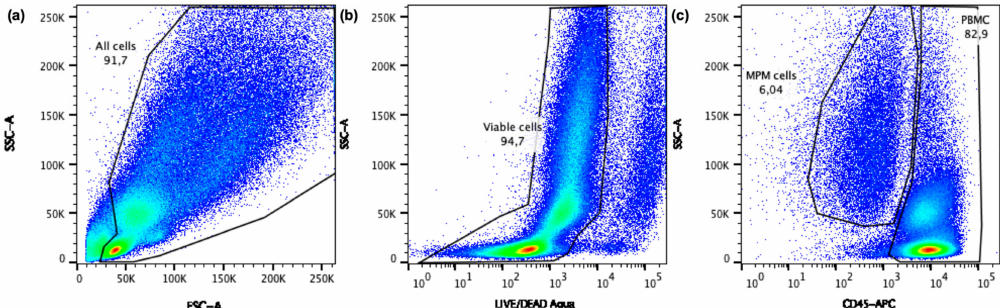
Figure 6. Flow cytometry gating strategy. The dot plots show the subsequent gates that were drawn to analyze the immune checkpoint expression on MPM cells as well as on healthy donor PBMC. ( a ) Debris was excluded based on SSC versus FSC, ( b ) then dead cells were eliminated based on SSC versus Alexa Fluor 430, ( c ) and finally MPM cells and PBMC can be distinguished within the viable population based on the expression of